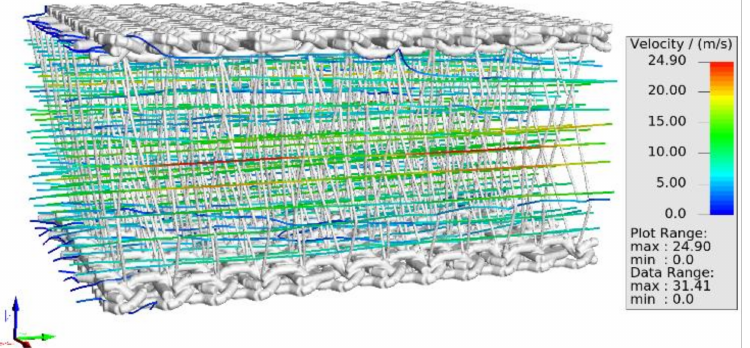
Figure 12. Flow stream lines of horizontal non-viscous fluid flow through a spacer fabric.